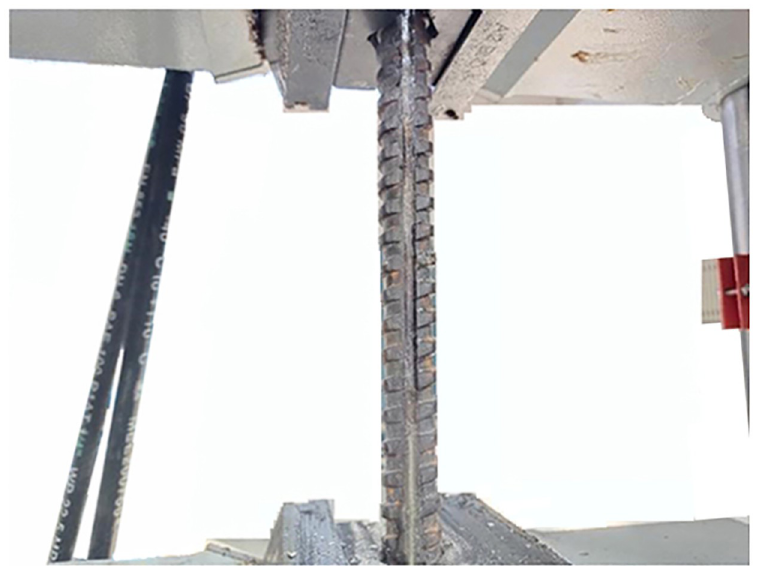
Fig 9. Steel bolt tensioned on the test machine.